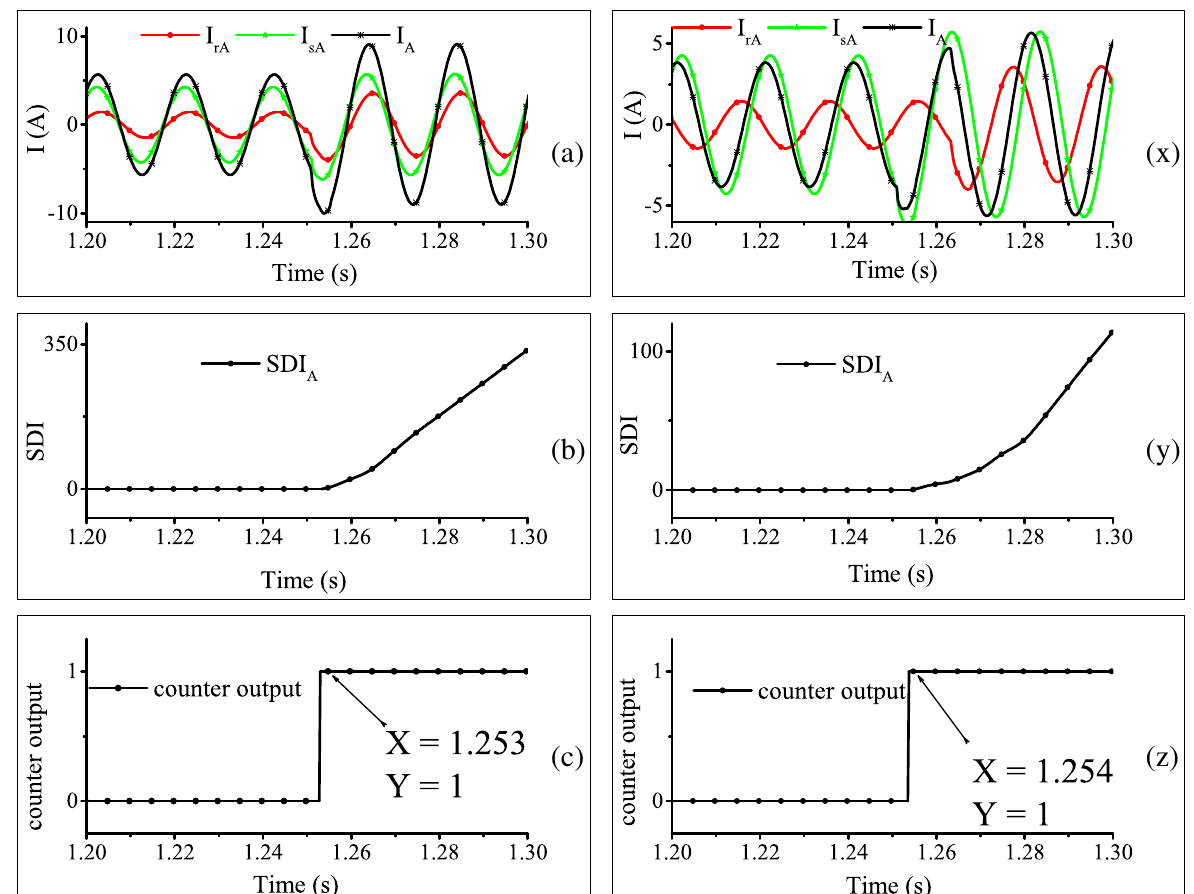
Fig. 9 Performance during remote data latency: ( a ) Current waveforms, ( b ) SDI trajectories ( c ) Counter output at ordinary case (before the delay in the current of the remote terminal). ( x ) Current waveforms, ( y ) SDI trajectories ( z ) Counter output after 10 ms delay of the remote-terminal current (I rA ) from its original